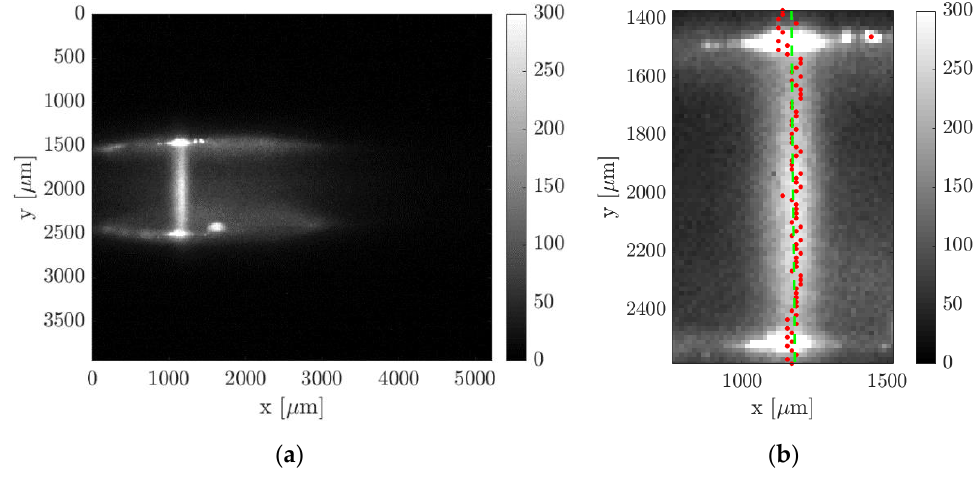
Figure 10. Post-processing procedure for detecting the initial position of the tagged line: ( a ) raw image of acetone early emission and ( b ) fitting of the maximum intensity along the y -coordinate detected in the region of interest.